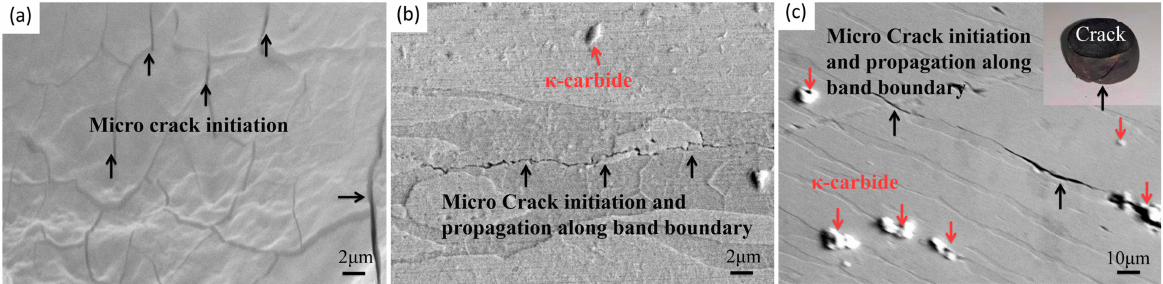
Figure 11. SEM images under conditions of ( a ) 900 ◦ C, 1 s − 1 , ( b ) 900 ◦ C, 2.5 s − 1 , and ( c ) 900 ◦ C, 20 s − 1